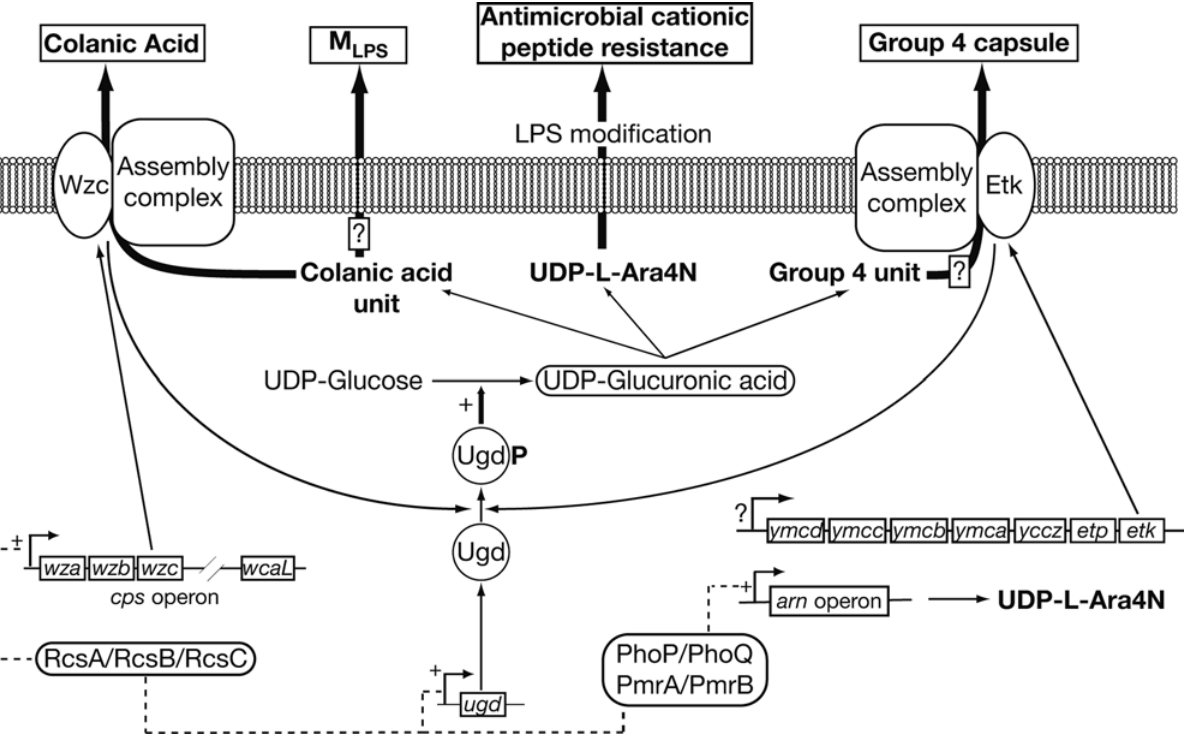
Figure 5. Schematic model for Ugd phosphorylation by Wzc or Etk as control element for extracellular polysaccharides production and resistance to antimicrobial cationic peptide. The two-component systems PhoP/PhoQ and PmrA/PmrB, or the RcsA/RcsB/RcsC system alone allow expression of genes involved in L-Ara4N production ( arn and ugd ) or colanic acid biosynthesis ( cps operon and ugd ), respectively. In both situations, phosphorylation of Ugd by Wzc and/or Etk influences UDP-glucuronic acid production and consequently the two phenotypes. Since, Ugd is involved in M LPS and Group 4 capsule synthesis, it is assumed that Ugd phosphorylation could also influence their production (boxed question mark symbols). A question mark symbol is also used to indicate that the mechanisms governing the expression of the ymc operon are still